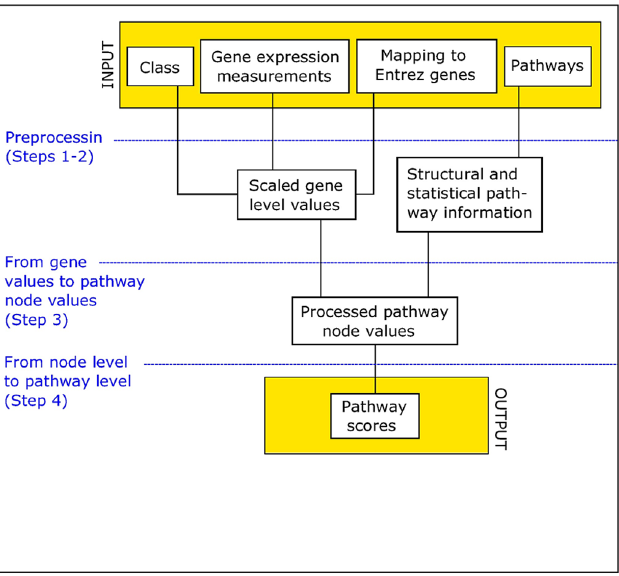
Fig 1. Workflow of the pathway analysis for sample-level information PASI. The method involves four steps described briefly above and in more detail in S1 Appendix.